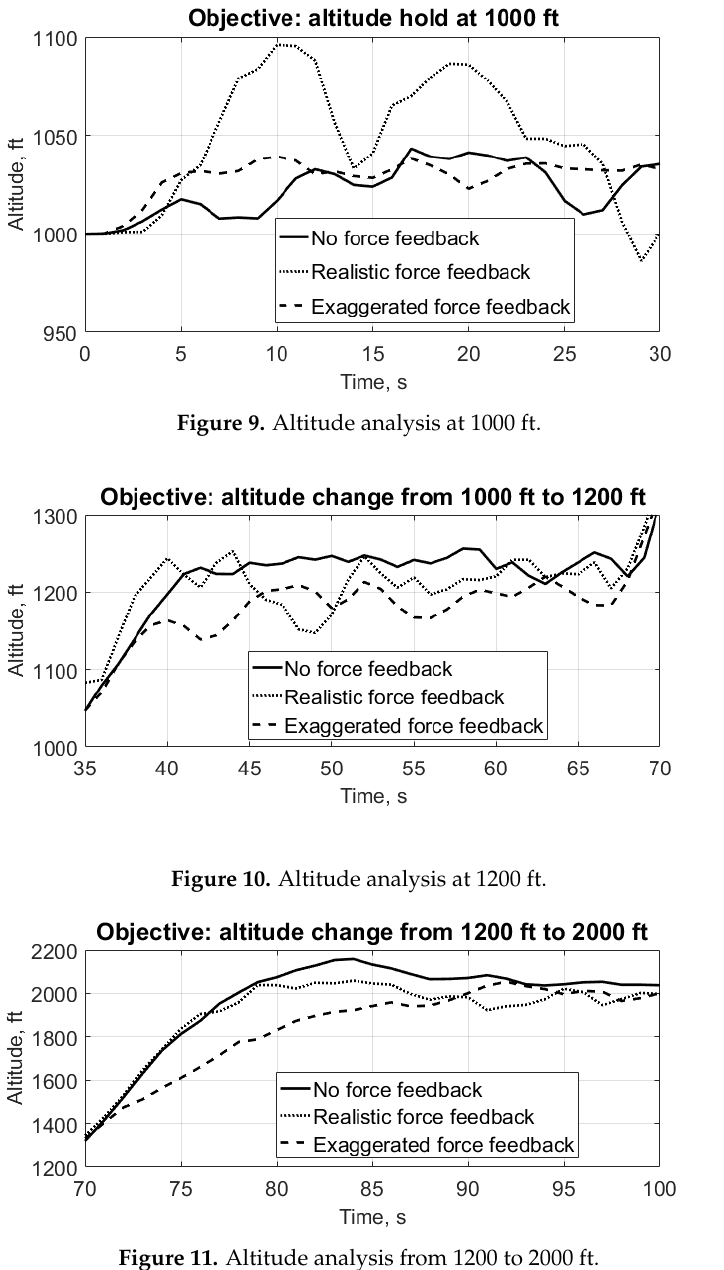
Figure 11. Altitude analysis from 1200 to 2000